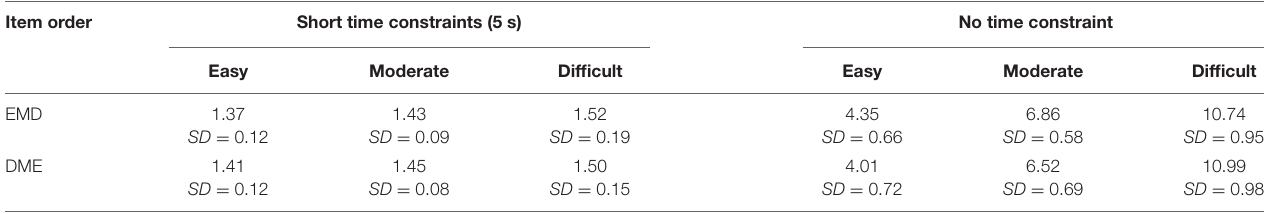
TABLE 7 | Self-paced study time in seconds for Experiment 3b (Ms, SDs). Item